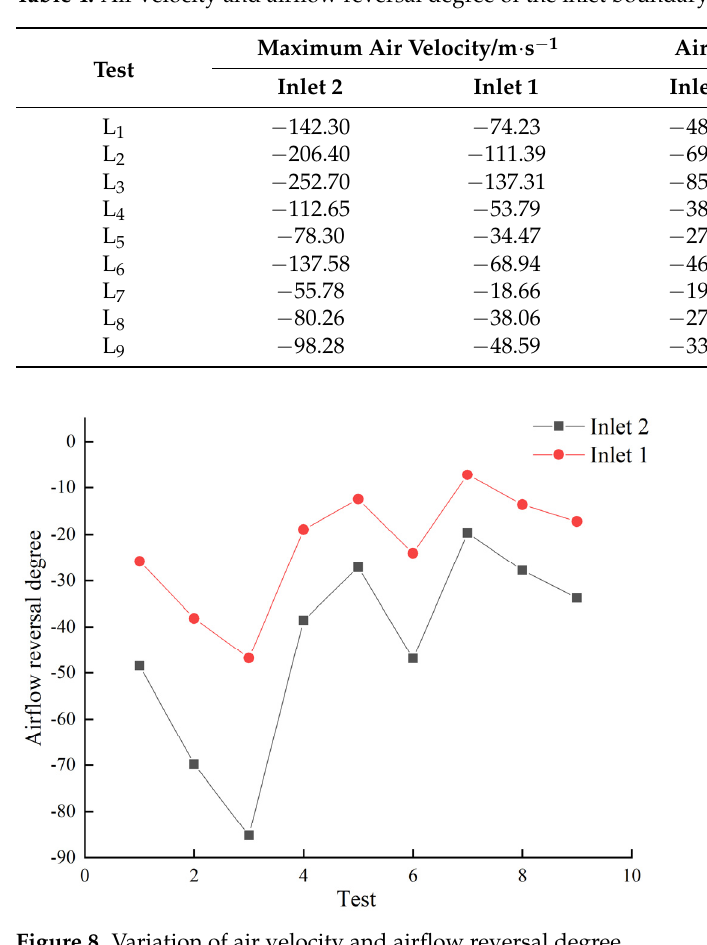
Figure 7. Air velocity of Inlet 1 of the intake airway.